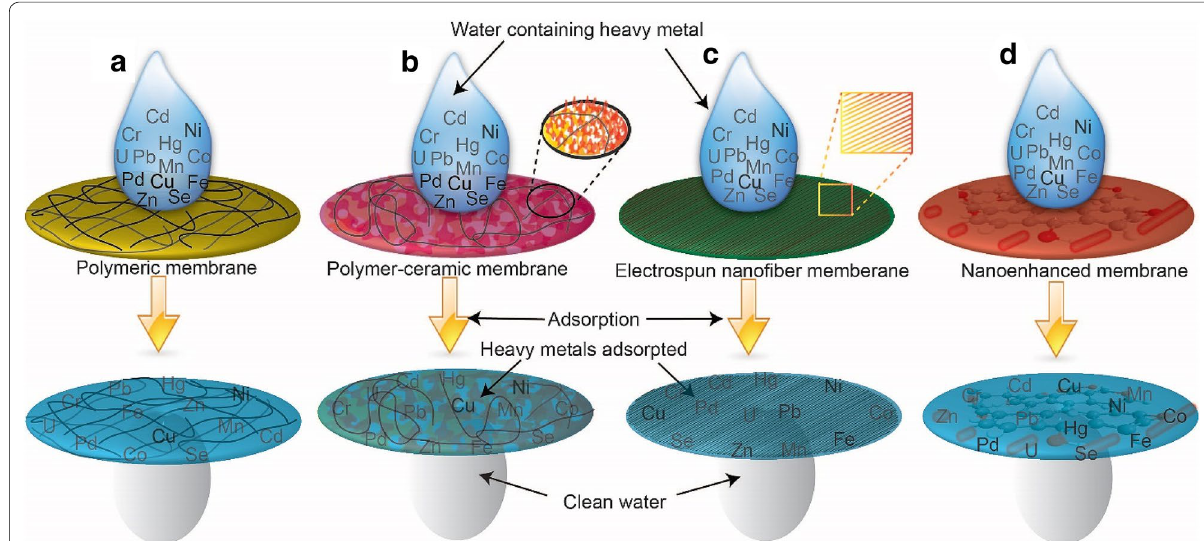
Fig. 1 Scheme of different adsorptive membranes (AMs) in the removal of heavy metal. a polymeric membranes (PMs) are created from polymer source materials, b polymer-ceramic membranes (PCMs) are created from a combination between polymeric and ceramic (natural clay materials: bentonite, kaolinite, and montmorillonite) materials, c electrospinning nanofiber membranes (ENMs) are created from electrospinning method for forming fibers with nanometer to micron diameters, and d and nano-enhanced membranes (NEMs) are created from incorporating nanomaterials (carbonaceous materials, nanometal or nanometal oxides, and other organics)